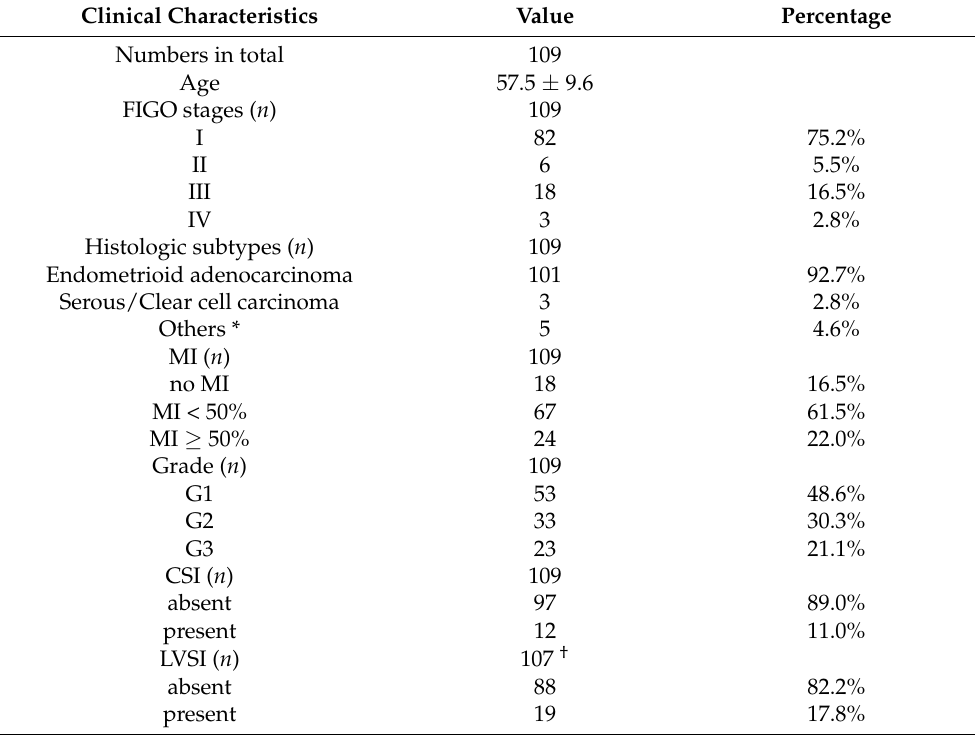
Table 2. Clinical characteristics of patients with endometrial cancer. Clinical